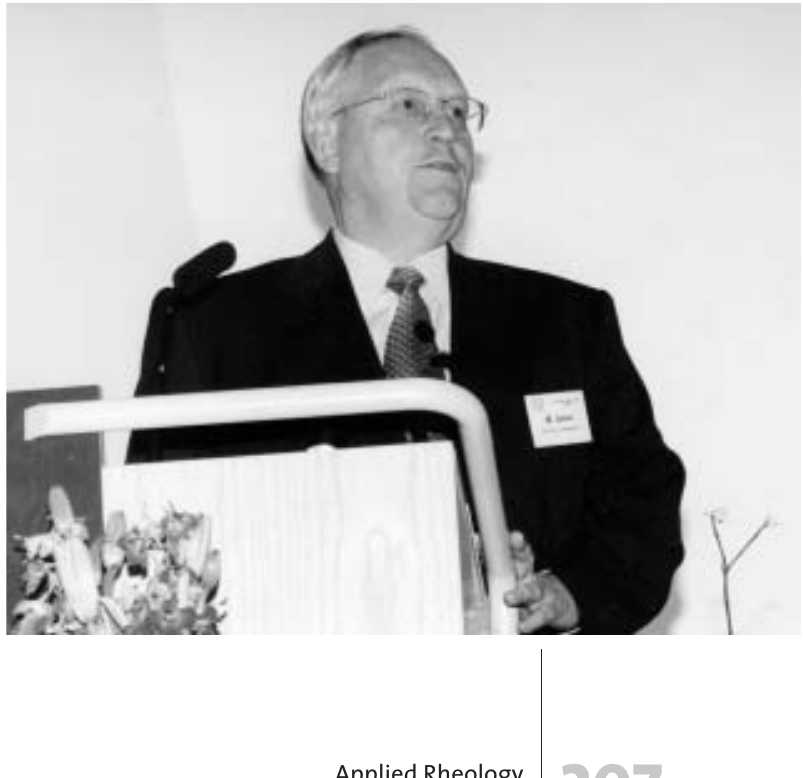
Figure 1 (left above): BAM Figure 2 (left below): Exhibition Figure 3 (right): M.